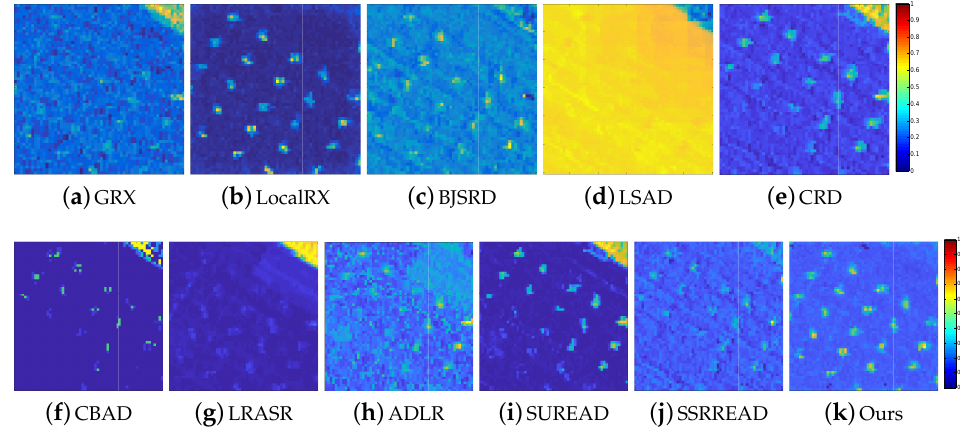
Figure 13. 2-D target probability color maps of the detection algorithms for the Sandiego60 dataset.